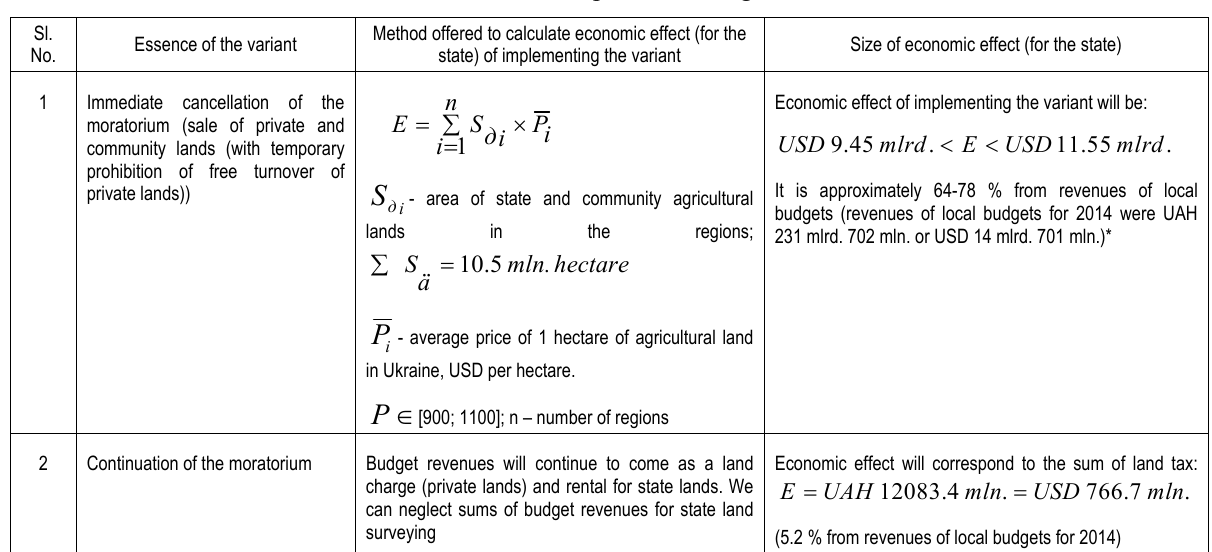
Table 2. Calculation of economic benefit of continued implementation options (cancel) the moratorium on the sale-purchase of agricultural land